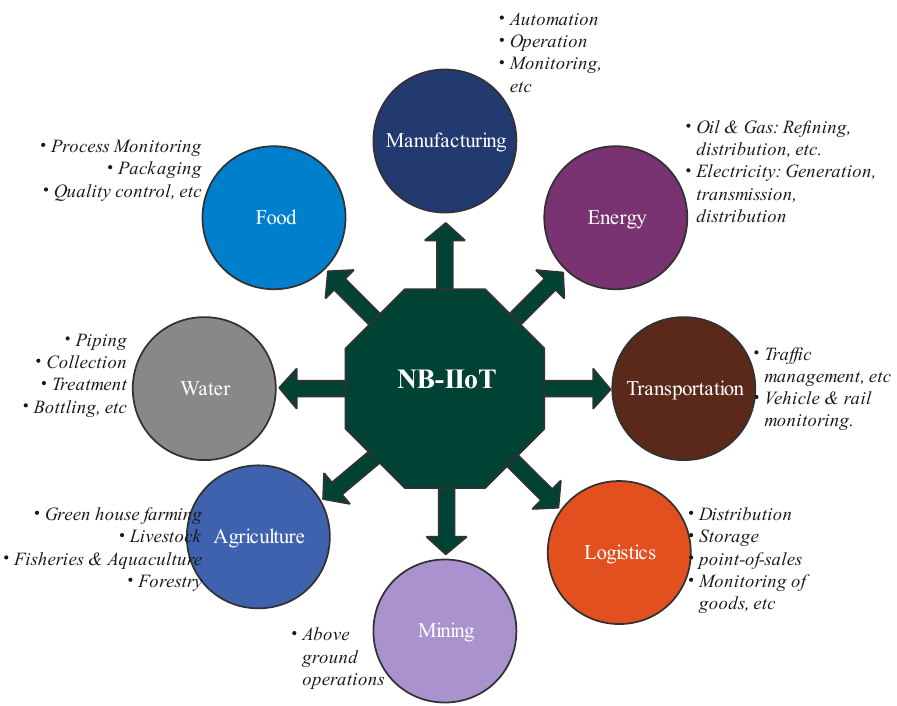
Figure 13. Areas of NB-IoT applications in